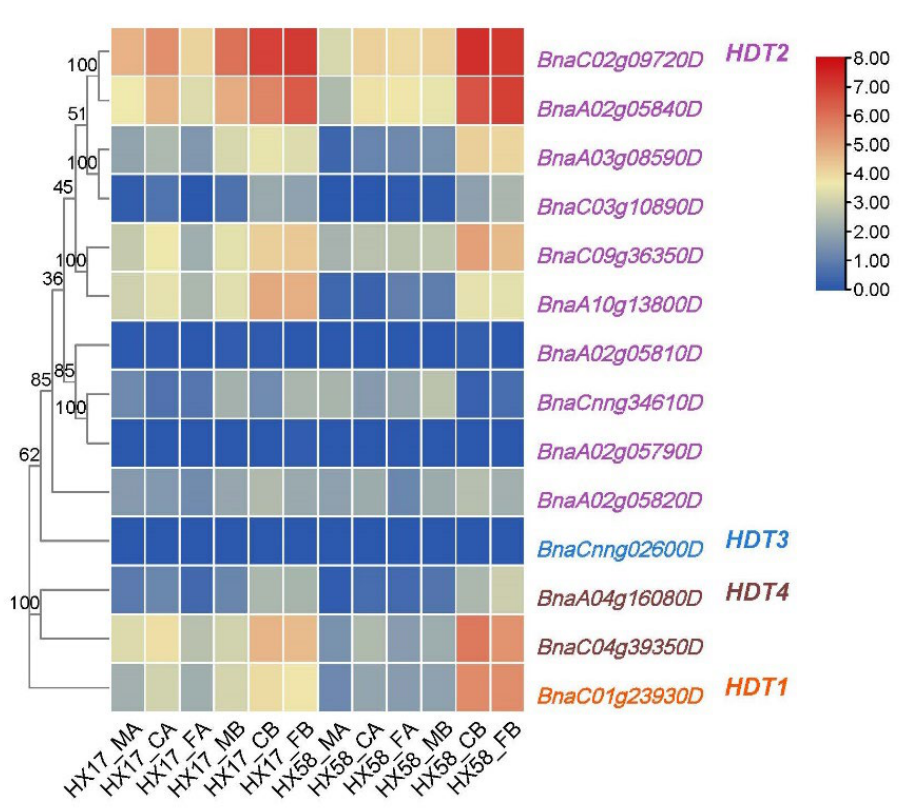
Figure 6. Expression of BnaHDT genes under different low-temperature treatments.